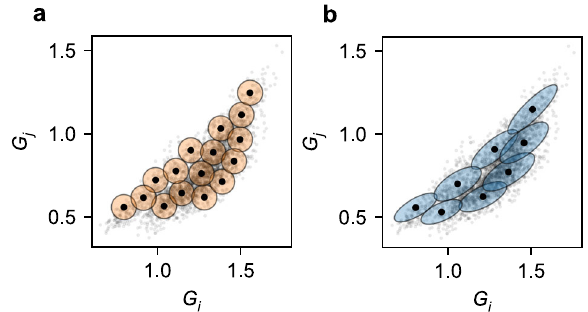
Fig. 1 The schematic description of bias potential shape in the G space projected on certain components G i and G j . a Isotropic Gaussian potential with a fi xed width. b Adaptive Gaussian potential. Gray dots represent the G vector points sampled during the MD simulation. Black dots represent the G vector points where bias potential is evaluated and semi-transparent circles and ovals represent bias potentials centered on the black